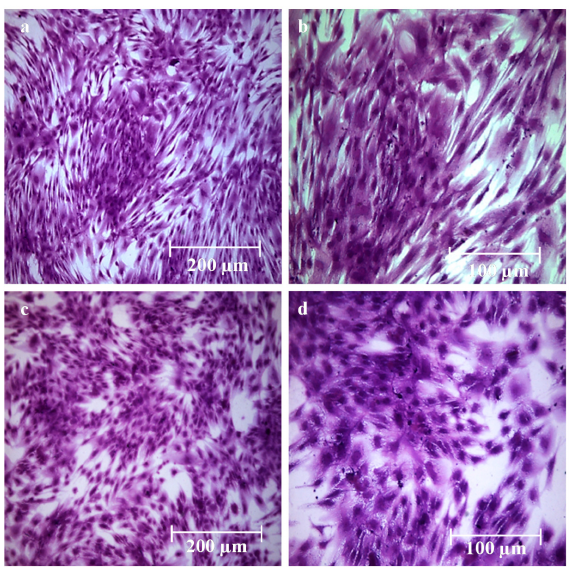
Figure 3. ( a , b ) Microscopic images of mesenchymal stromal cells (MSC) cultured for seven days in control culture medium after crystal violet staining; ( c , d ) microscopic images of MSC cultured for seven days in 0.1% chitosan hydrochloride culture medium after crystal violet staining. (Reprinted from reference [20]).